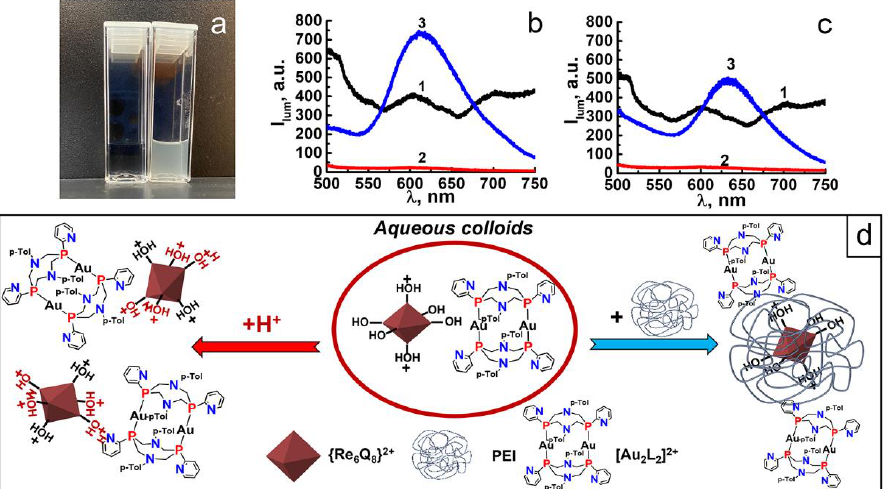
Figure 3. ( a ) Photos of Au 2 Re 6 -Q colloids before (right) and after (left) the addition of PEI. ( b,c ) Luminescence data for Au 2 Re 6 -S ( b ) and Au 2 Re 6 -Se ( c ): 1 – colloids; 2 – corresponding colloids after treatment by PEI; 3 – supernatants. ( d ) Schematic representation of Au 2 Re 6 -Q colloids dissolution upon acidification and treatment by PEI.